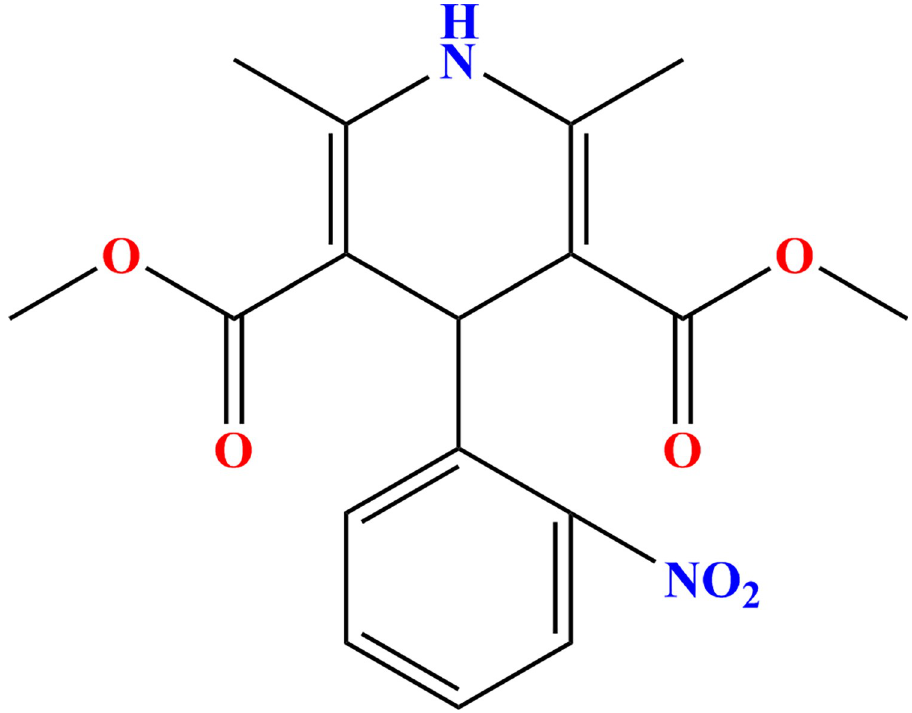
Fig 1. Structural formula of